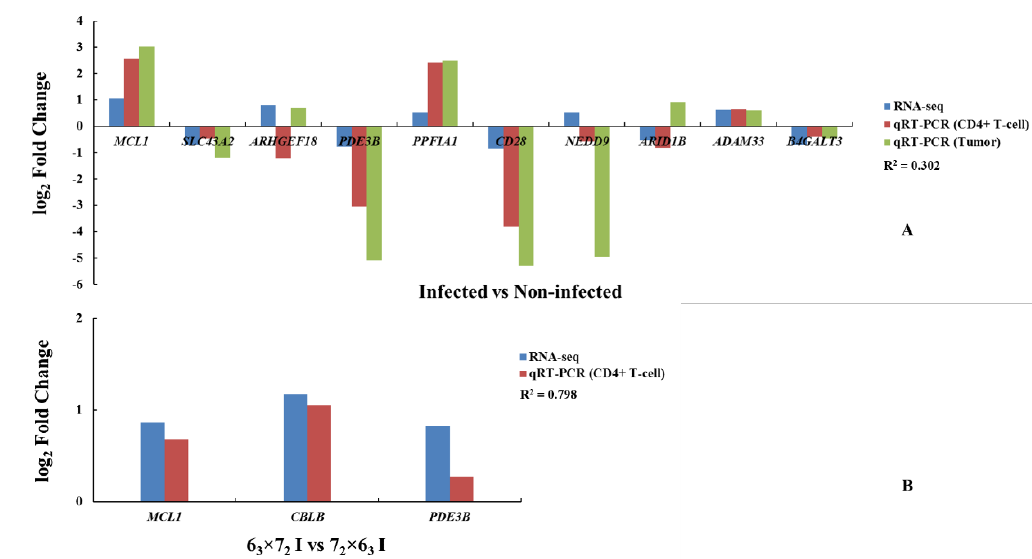
Figure 6. Gene functional validation in CD4 + T cells and tumors using qRT-PCR: ( A ) Infected in contrast to non-infected; ( B ) infected comparison groups between two reciprocal crosses. The y-axis represents the log 2 FC of gene expression; the x-axis shows the genes employed for validation. Blue, red, and green bars depict the RNA-Seq and qRT-PCR of genes in CD4 + T cell and tumor results, respectively. R 2 refers to the coefficient of determination.